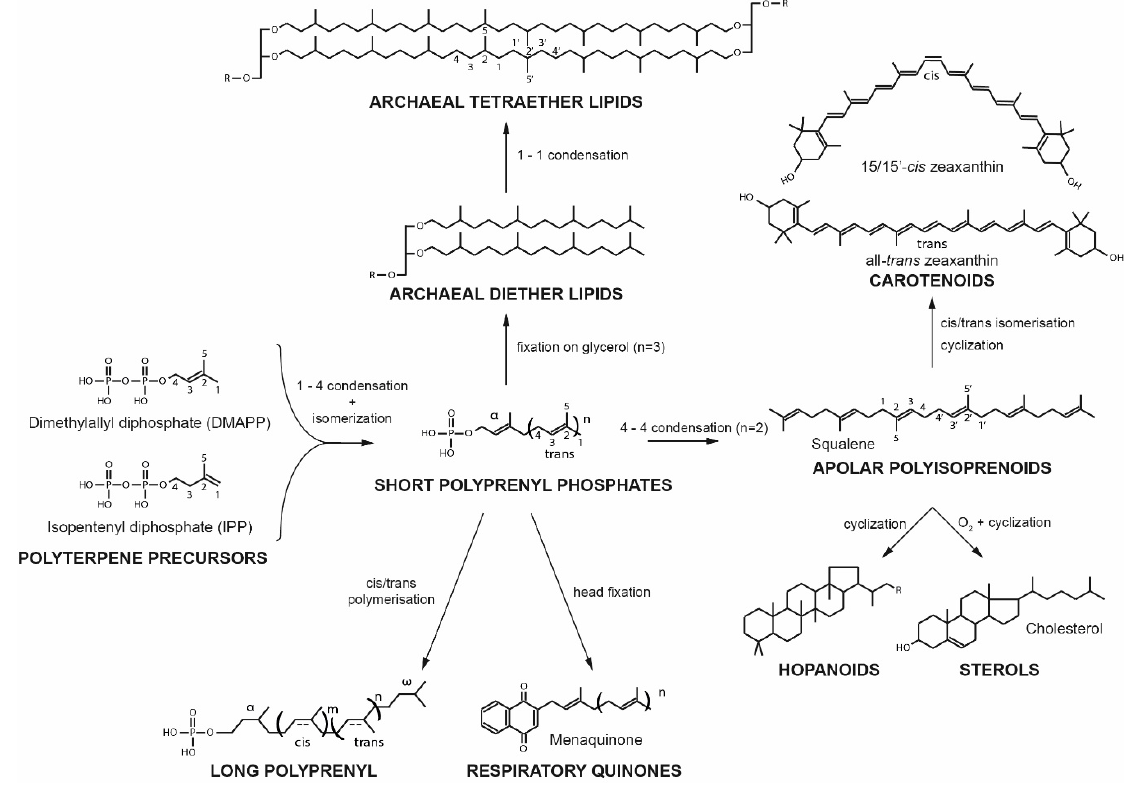
Figure 1. Most representative polyterpenes and their biosynthetic link. Carbon nomenclature and isoprene conformations are indicated as mentioned hereafter.